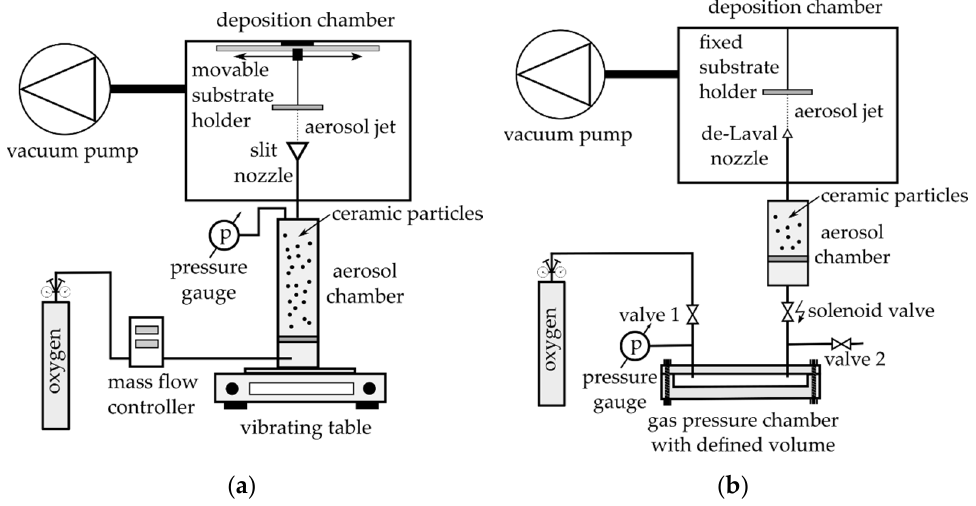
Figure 1. Schematic drawing of the PAD apparatus: ( a ) conventional PAD apparatus; ( b ) novel DPAD apparatus.